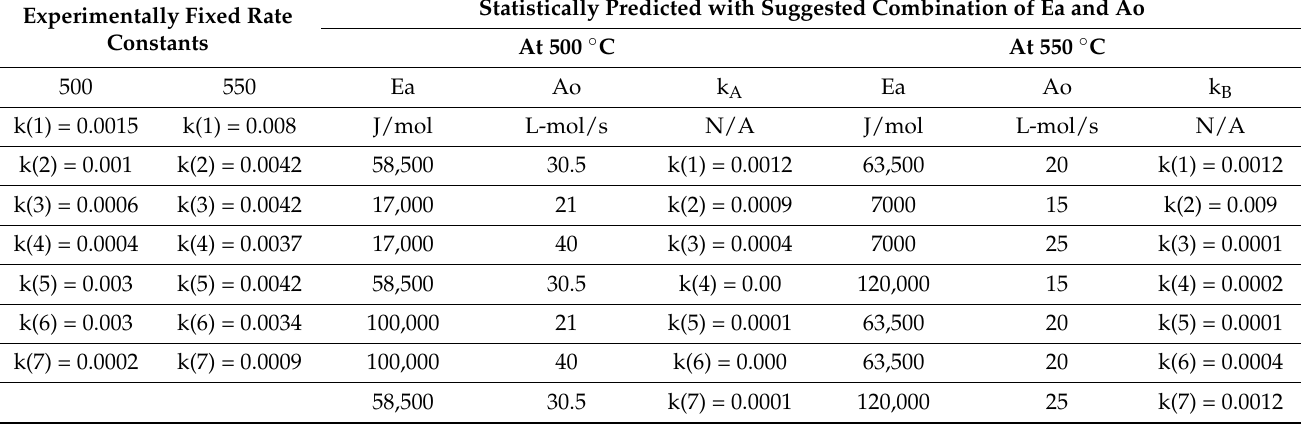
Table 5. The predicted rate constants with suggested Ea and Ao at different temperatures.